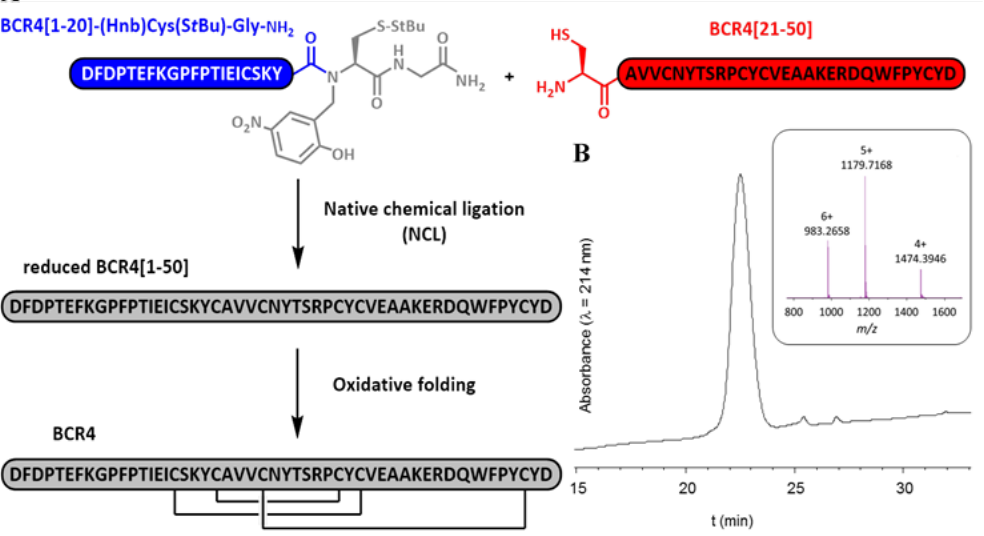
Figure 2. Chemical synthesis of BCR4. ( A ) Schematic representation of the BCR4 peptide chemical through native chemical ligation (NCL) of two peptide segments BCR4[1-20] in blue and BCR4[21-50] in red, followed by oxidative folding to form the three disulfide bridges. ( B ) RP-HPLC chromatogram and ESI-HRMS mass spectrum of the purified folded